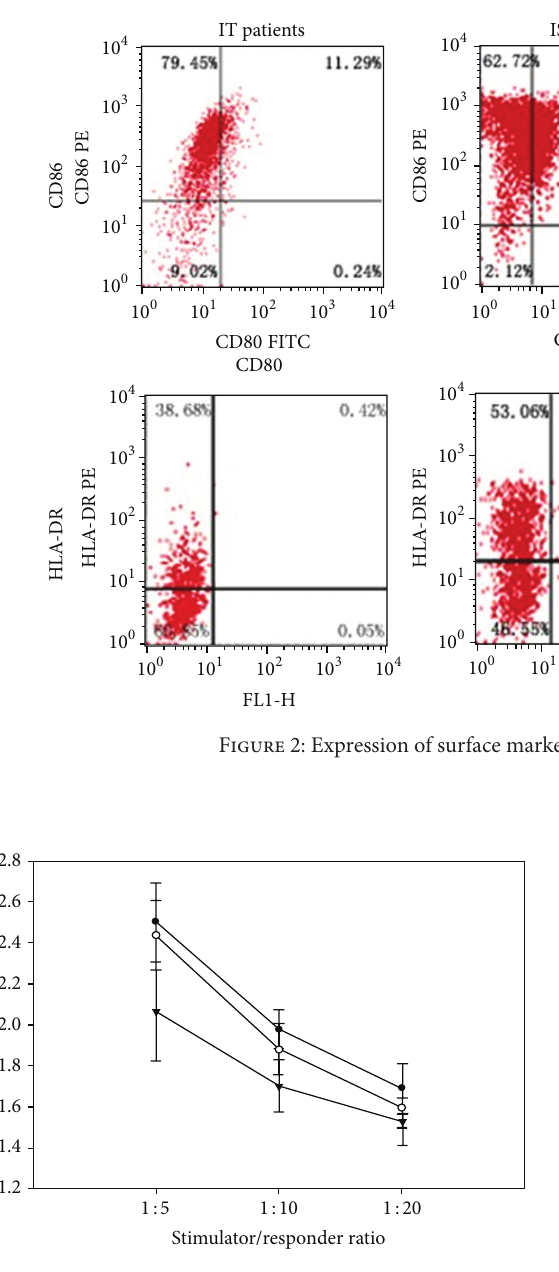
correlation between HBV DNA level and the